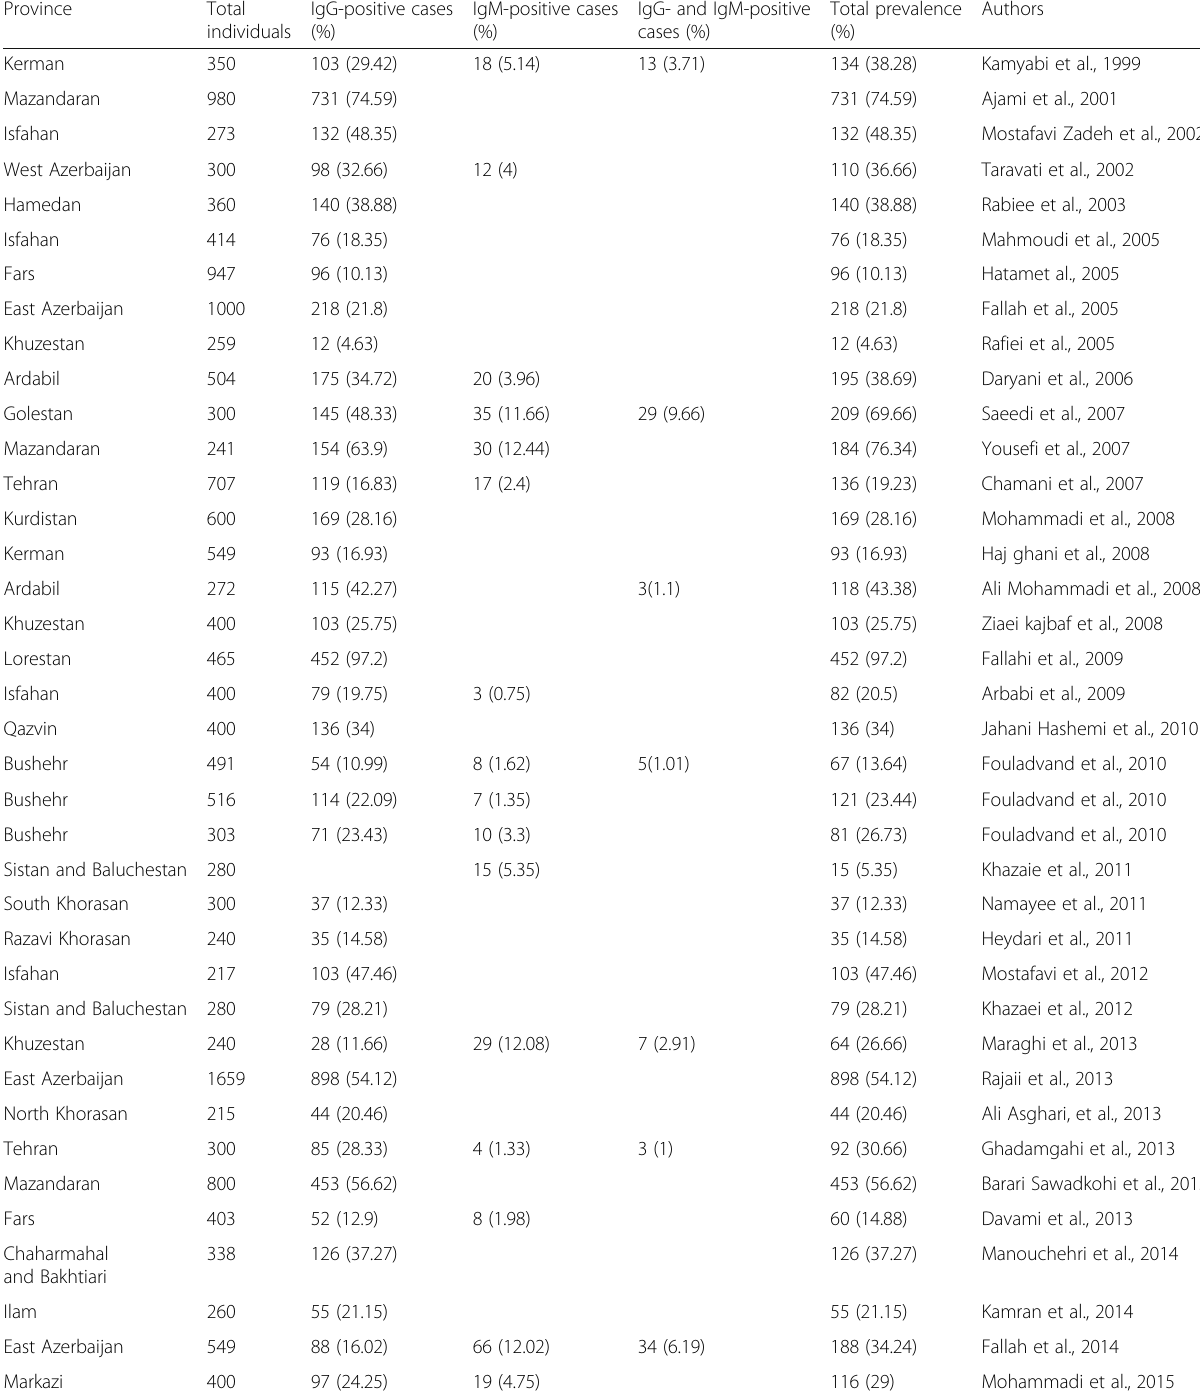
Table 1 Girls and women of childbearing age group baseline characteristics of included studies Province Total IgG-positive cases individuals